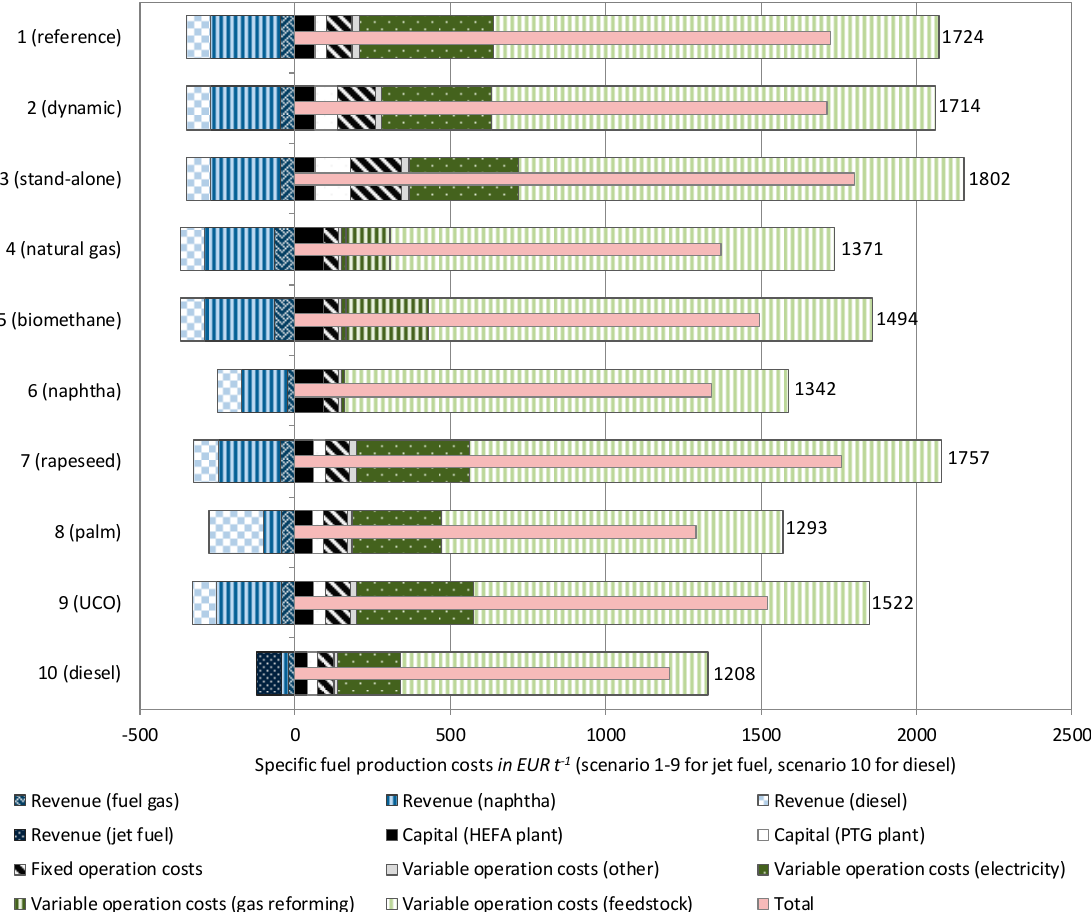
Figure 4. Specific fuel production costs per scenario.